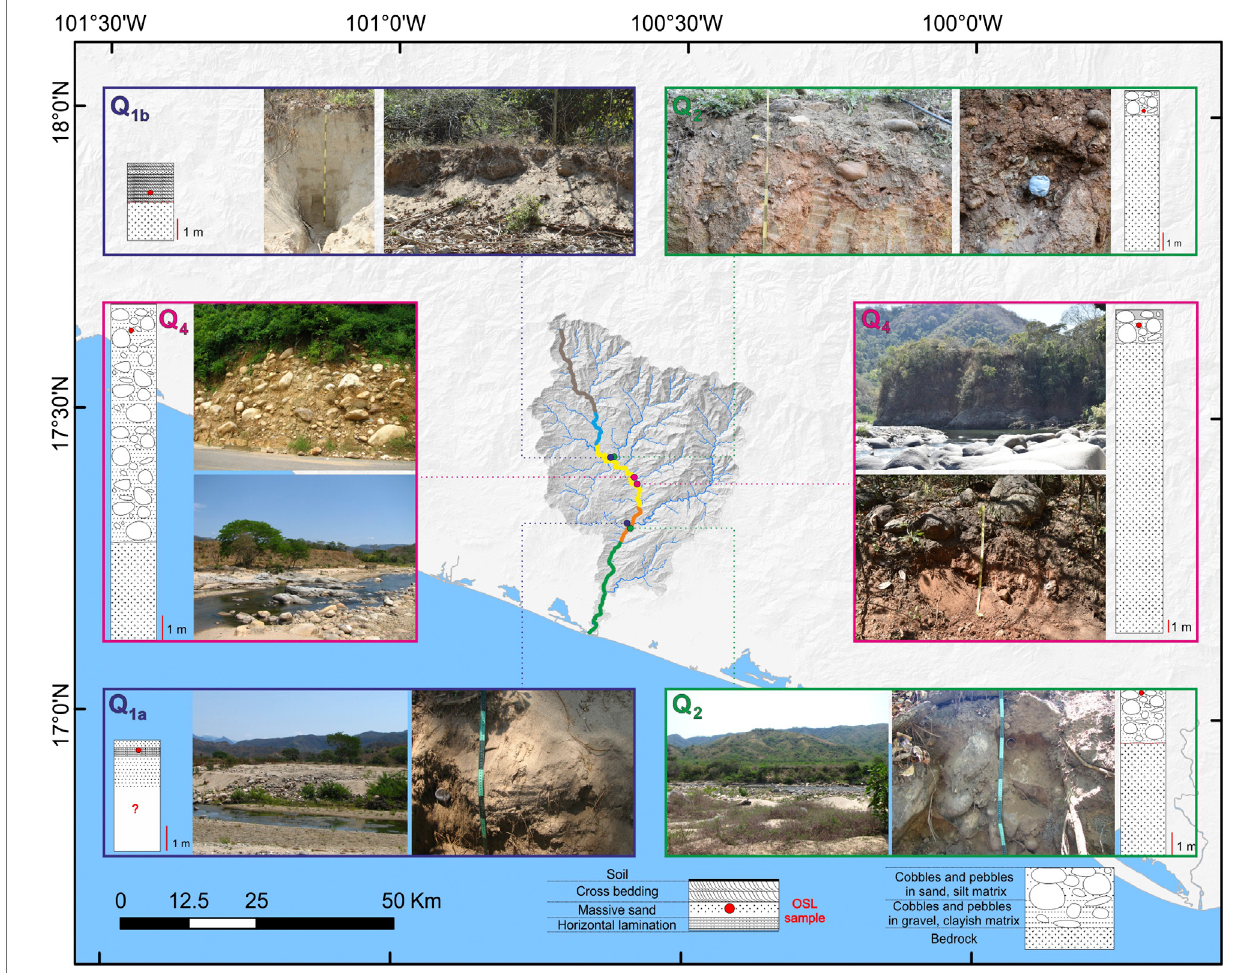
FIGURE7| High-resolutiondigitalelevationmodel(10 cmhorizontal resolution) obtainedfrom eBeeunmanned aerialvehicle(UAV)photographsshowingterraces distribution in the Tecpan valley in segment no. 3; the dashed line shows the location of the pro fi le AB presented in the lower part of the fi gure. The inset shows the location of the presented DEM (black